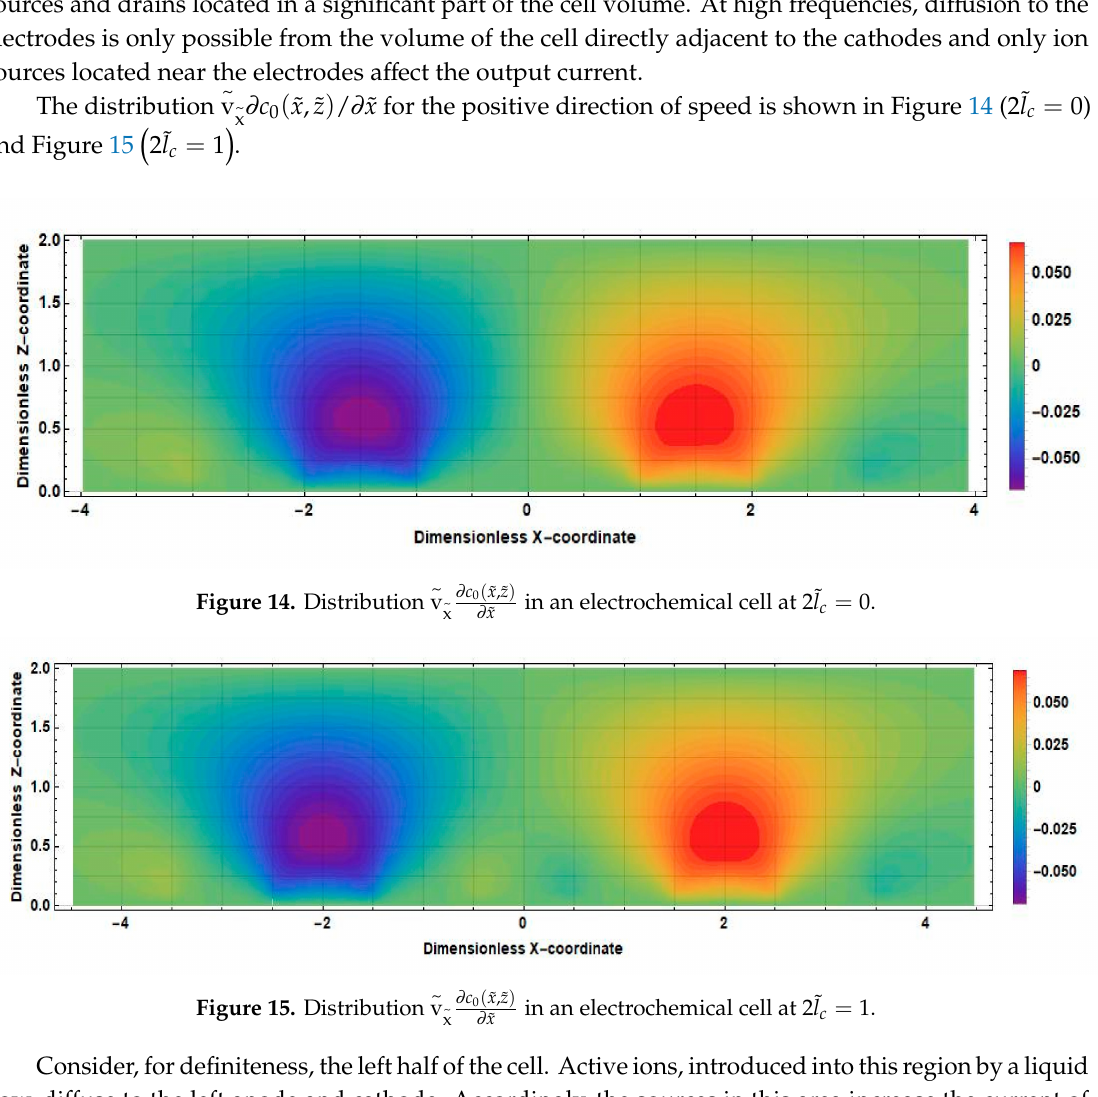
Figure 15. Distribution